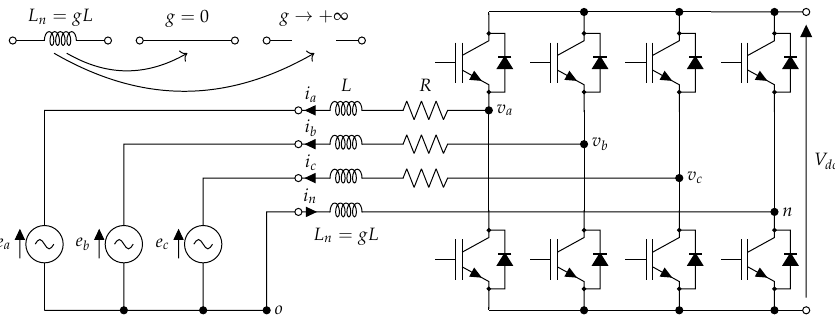
Figure 1. Grid-connected three-phase four-wire four-leg inverter.